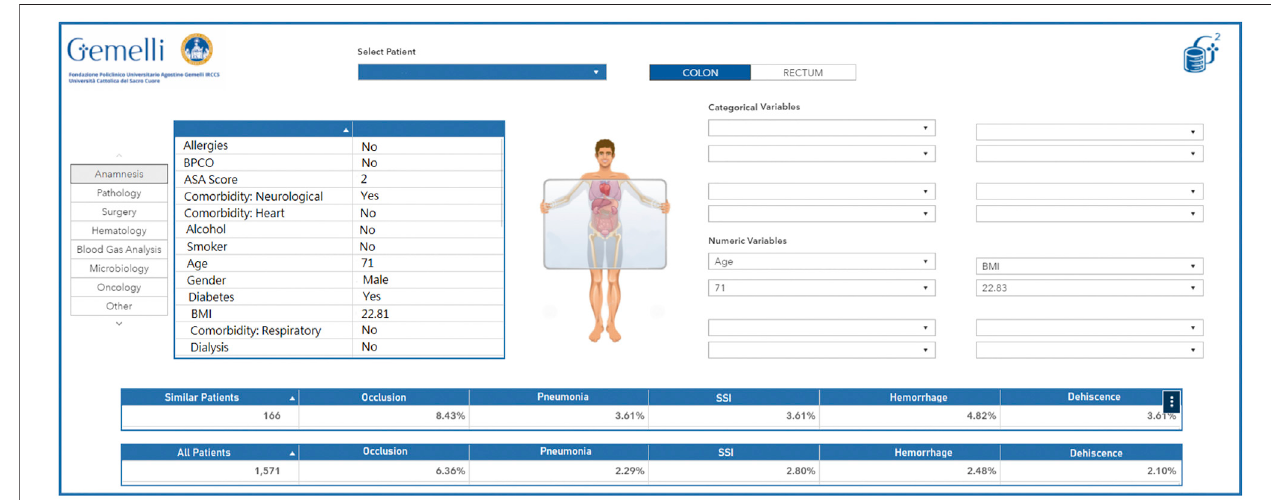
FIGURE 8 | Avatar representation of a fi ctitious example patient.